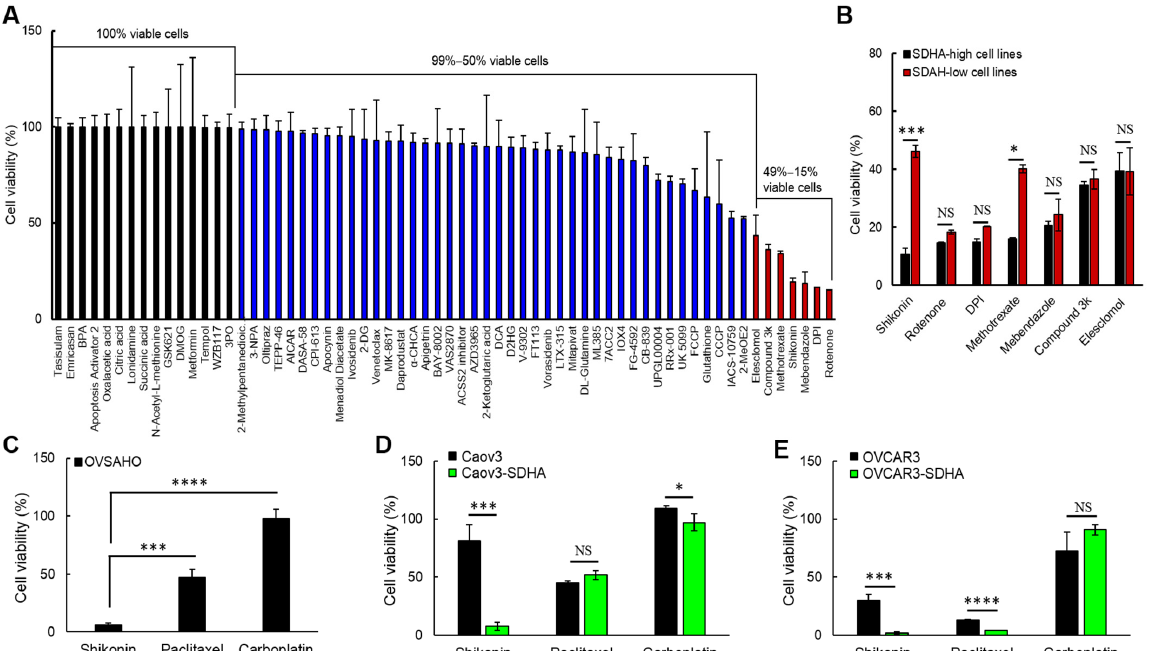
Figure 8. The SDHA overexpressing cell lines are highly sensitive to shikonin. ( A ) Ovarian cancer cell lines (OVCAR3, OVCAR4, TYKnu, and OVSAHO) were exposed to anti-metabolic compound library. The most potent agents are denoted in red. ( B ) The anti-cancer efficacy of the most potent compounds was evaluated in SDHA-high vs. SDHA-low cell lines. Shikonin was the most effective agent in specifically killing SDHA overexpressing cells. ( C – E ) Ovarian cancer cell lines endoge- nously overexpressing SDHA (OVSAHO) or conditionally overexpressing SDHA (Caov3-SDHA and OVCAR3-SDHA) were treated with shikonin or chemotherapy (paclitaxel, carboplatin) to assess % of viable cells. ( C ) Shikonin is significantly more effective in killing OVSAHO cells than chemotherapy. ( D , E ) Cells overexpressing SDHA are significantly more sensitive to shikonin than respective controls. In cell lines overexpressing SDHA shikonin reduced cell viability more profoundly than carboplatin in both cell lines, and than paclitaxel in Caov3 cell line. ( A – E ) Data are represented as mean ± SEM; * = p < 0.05, *** = p < 0.001, **** = p < 0.0001, and NS = not significant (one-way ANOVA followed by post hoc Tukey’s test). For additional information see Supplementary Table S2 and Figure